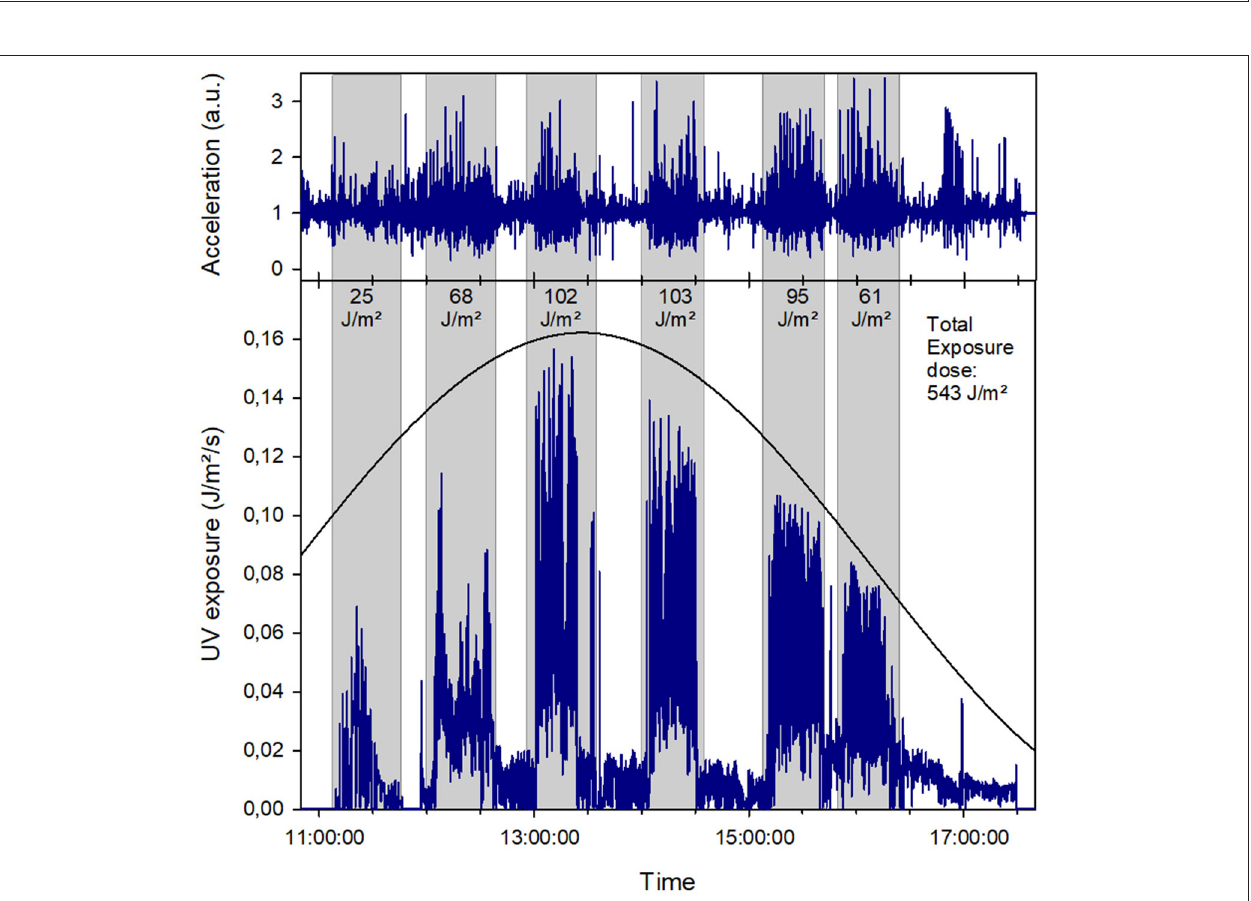
FIGURE 2 | Data from a competition that went on the whole day. Six matches were played during that time (marked by gray shading). For every single game, the respective irradiance is given. Total exposure doses gives the whole day exposure. The solid line represents the daily dependence of the global irradiance (without axis, only qualitatively) Top: accelerometer data; Bottom: UV exposure.